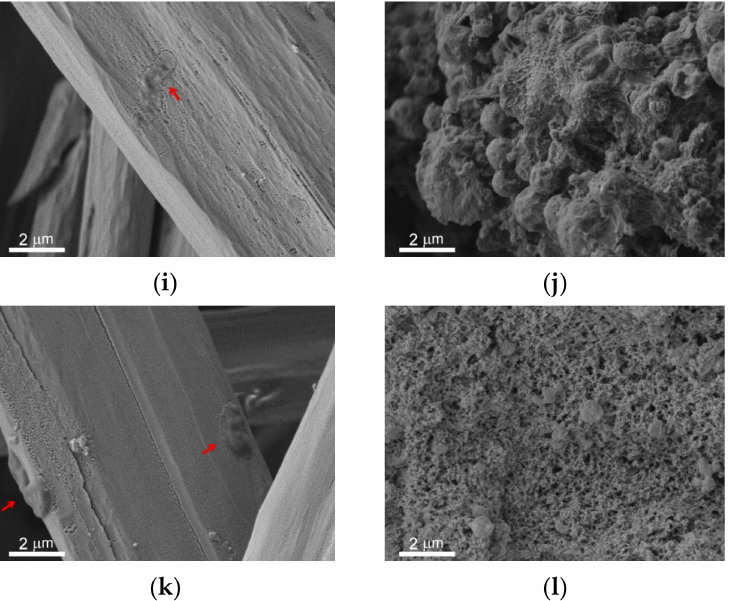
Figure 6. SEM images illustrating the morphology of the magnesium alloy samples with different wettability after immersion for 48 h into the bacterial dispersions in PBS. The images are arranged as follows. The horizontal rows of images correspond to different types of substrates and immer- sion liquids: ( a , b ) polished bare MA8 sample after immersion into the dispersion of K. pneumoniae ; ( c , d ) polished bare MA8 sample after immersion into the dispersion of P. aeruginosa ; ( e , f ) super- hydrophilic sample after immersion into the dispersion of K. pneumoniae ; ( g , h ) superhydrophilic sample after immersion into the dispersion of P. aeruginosa ; ( i , j ) superhydrophobic sample after immersion into the dispersion of K. pneumoniae ; ( k , l ) superhydrophobic sample after immersion into the dispersion of P. aeruginosa . Left column ( a , c , e , g , i , k ) presents magnified images of microrods deposited on the covering layer; right column images ( b , d , f , h , j , l ) show the structure of the layer covering the intrinsic texture of the substrate. Red arrows point bacterial cells deposited onto the rods or covering layers.